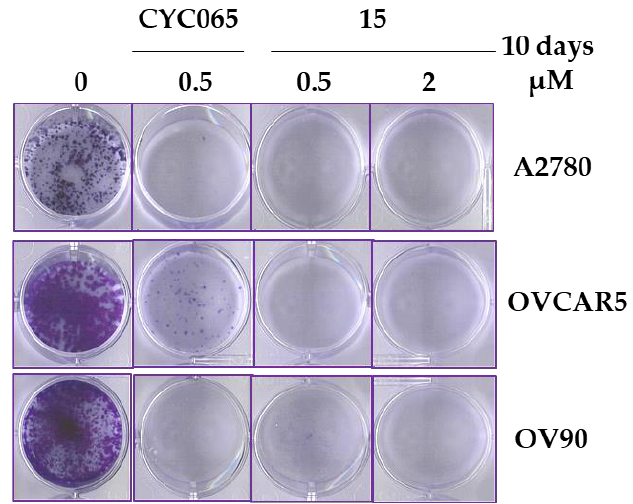
Figure 6. Effect of 15 on colony formation. Three different ovarian cancer cell lines were incubated with vehicle (DMSO), 0.5 or 2 µM 15 , or 0.5 µM CYC065 for 10 days. Colony formation was evalu- ated by crystal violet staining. Experiments were performed twice, and representative data are pre- sented.